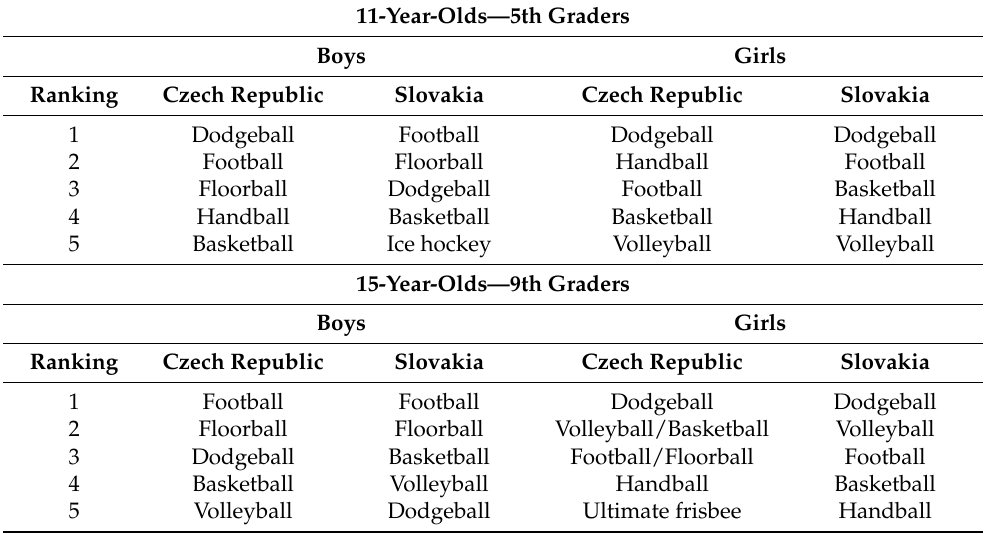
Table 6. The most preferred sports by grade